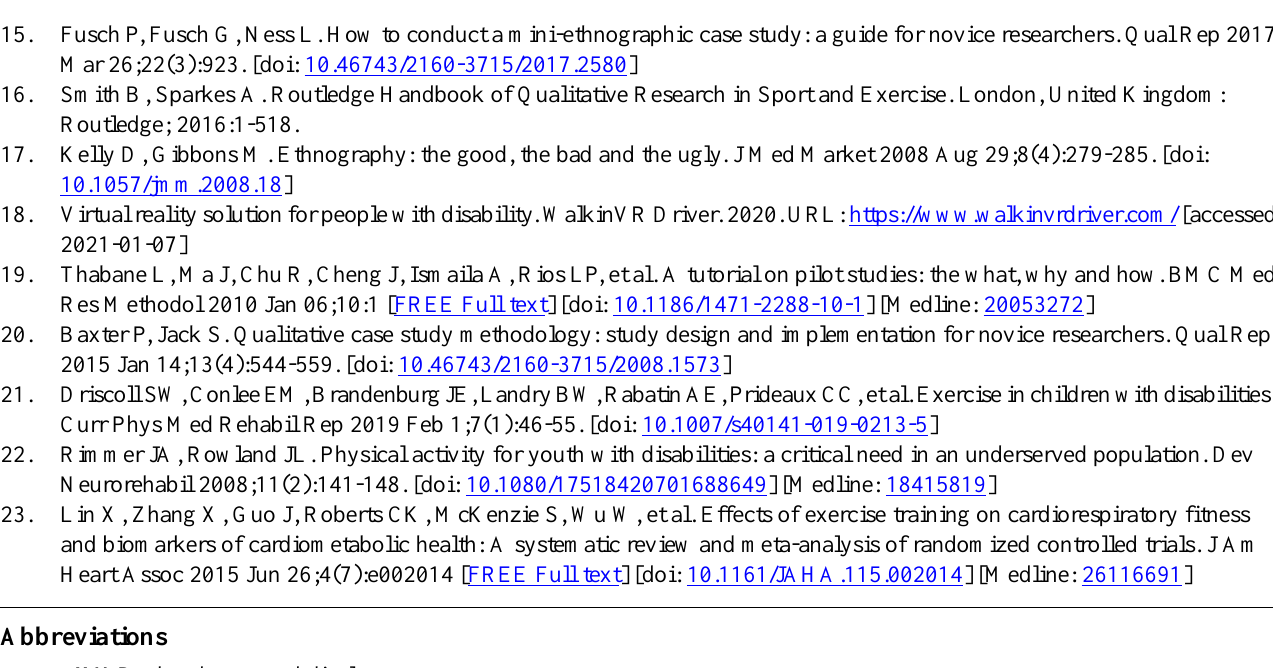
HMD: head-mounted